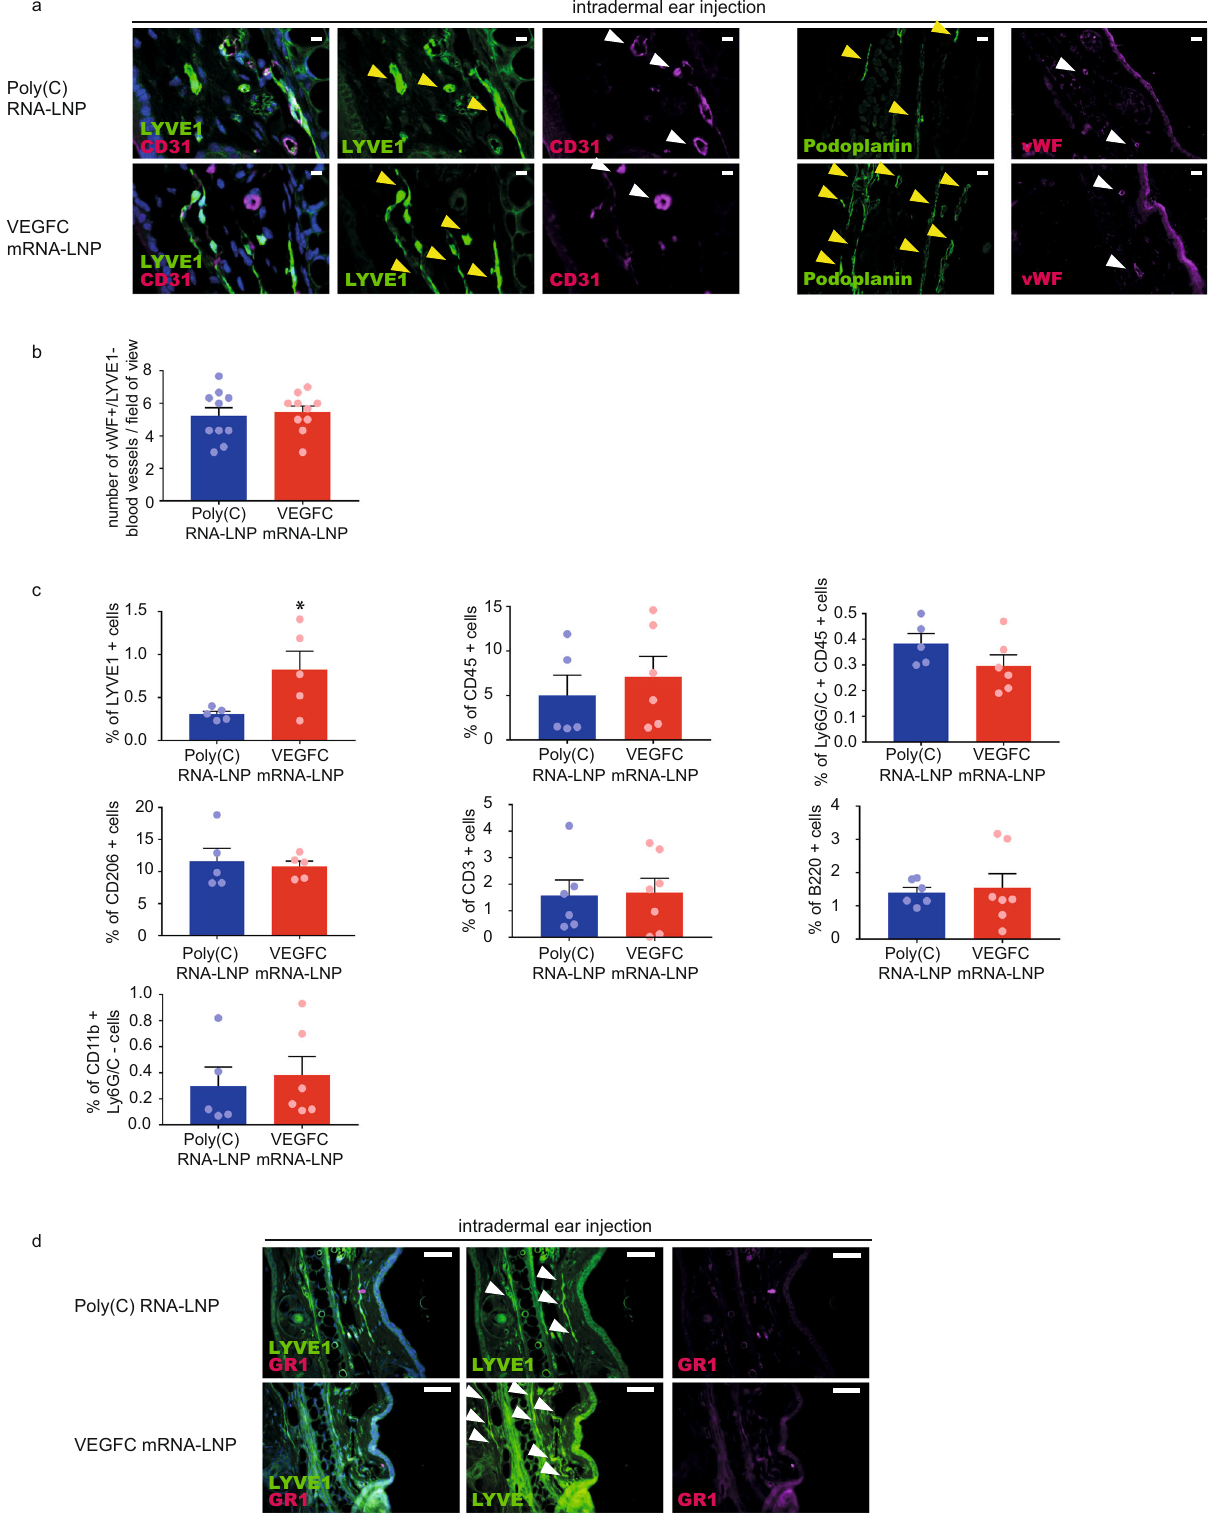
Collectively, our study describes the use of the nucleoside- modi fi ed mRNA in the fi eld of lymphatics and based on the data presented here we believe that the application of this platform is a viable strategy for the treatment of lymphedema. Our results represent a major advancement in the fi elds of mRNA therapy, vascular biology, and